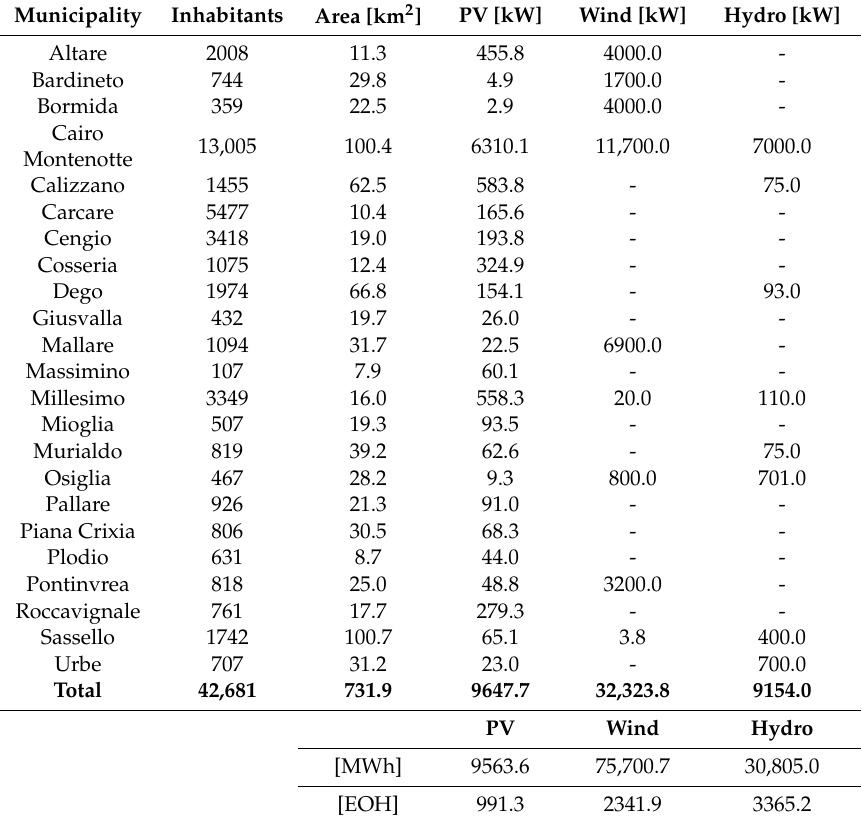
Table 3. Data of the Bormida Valley grouped by